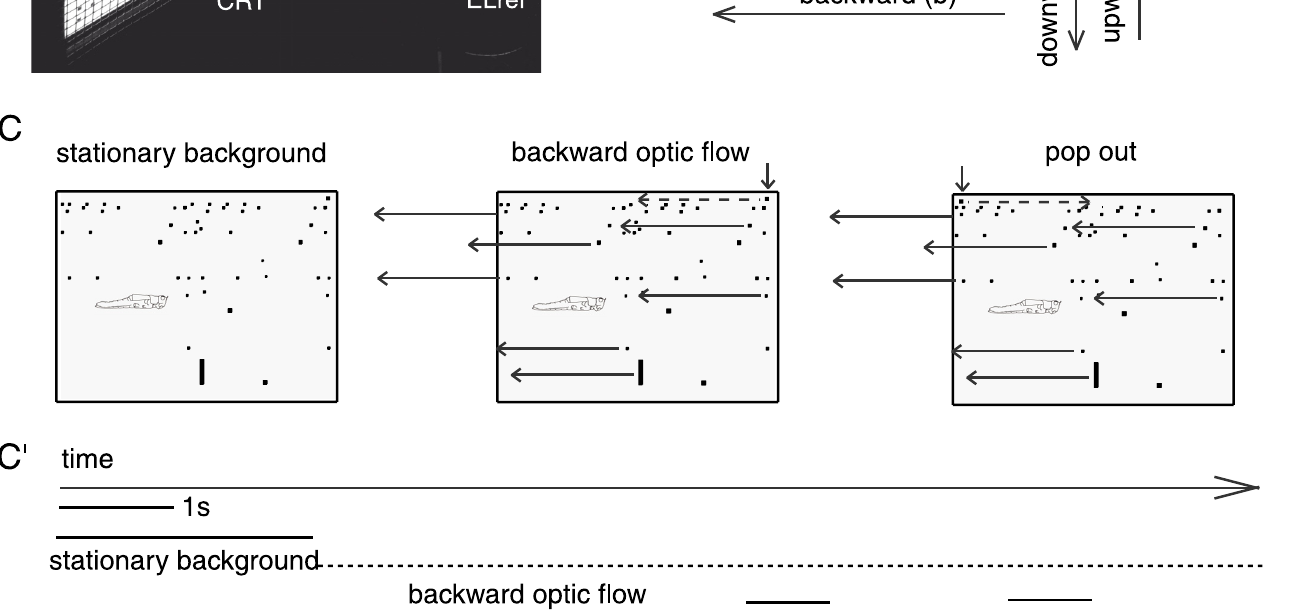
PLOS ONE | DOI:10.1371/journal.pone.0144501 December 4,